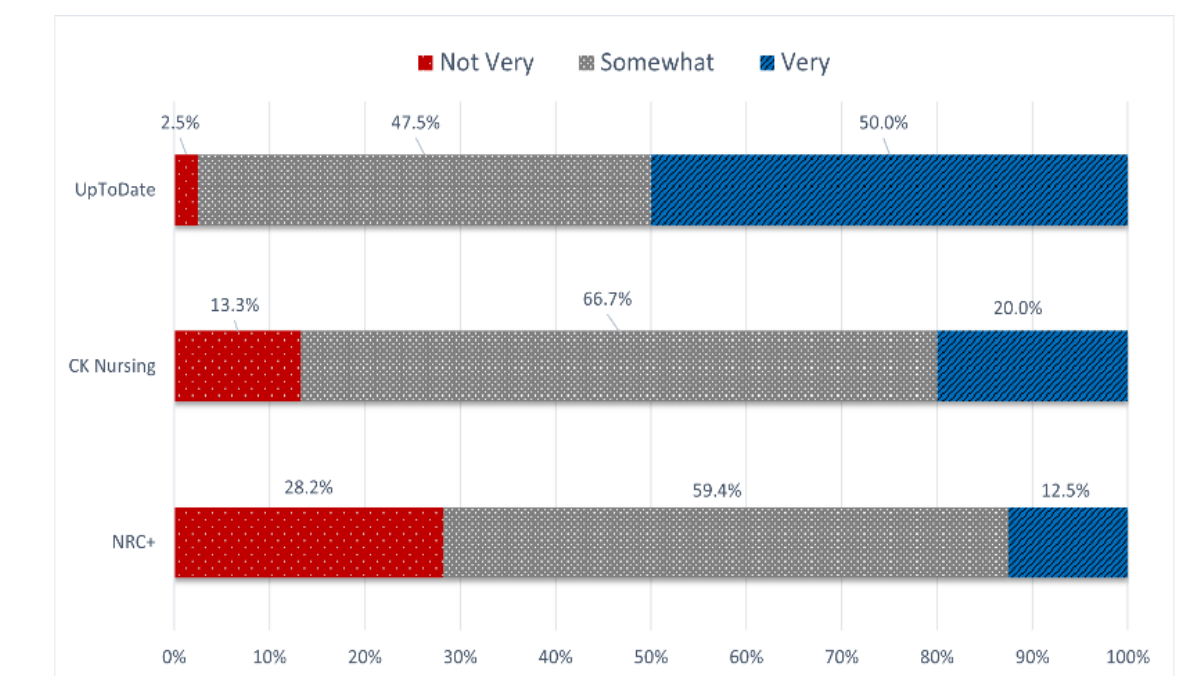
Figure 2 Nurses’ stated familiarity with